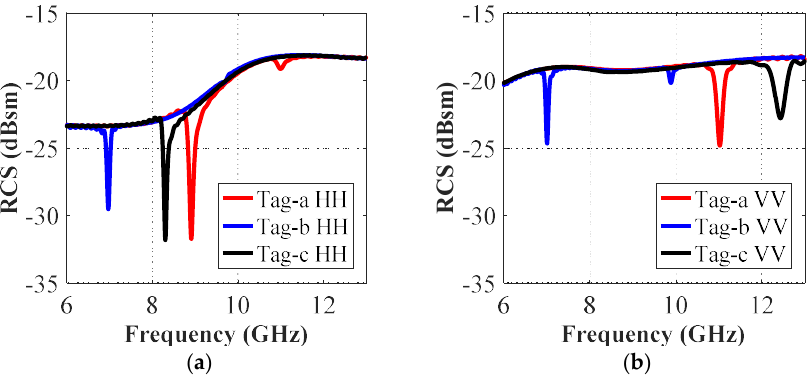
Figure 6. Co-polar RCS simulation results of tag-a, tag-b, and tag-c: ( a ) Co-polar HH RCS responses; ( b ) Co-polar VV RCS responses. Table 1. Unique frequency signature of single tag letters from Figure.